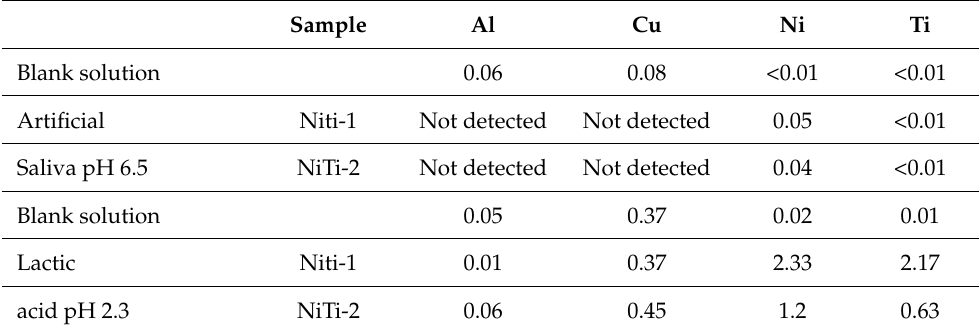
Table 4. ICP analysis results in µ g/cm 2 after 7 days of the immersion of NiTi-1 and NiTi-2 samples in artificial saliva (pH 6.5) and lactic acid (pH 2.3).